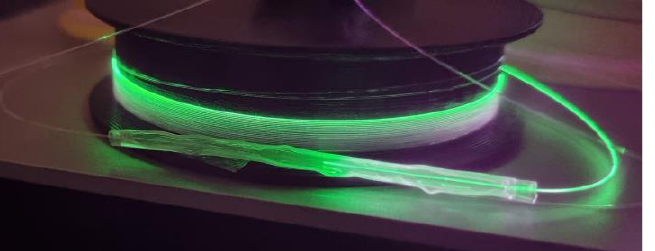
Figure 11. Green luminescence of the EYDF while pump is active. A purple tinge is also visible due to some pump light leaking from the fiber that is picked up by the camera. The fusion splice protection sleeve had its steel rod removed to avoid potential thermal expansion effects.